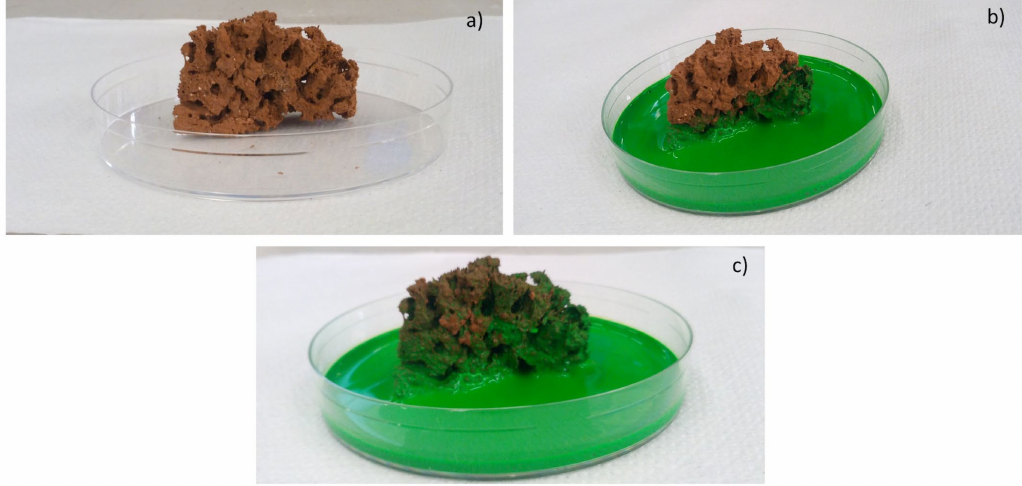
Figure 9. Images of the scaffold (SS FG50) before the contact with green ink ( a ); 2 s ( b ) and 2 min ( c ) after the contact with green ink.